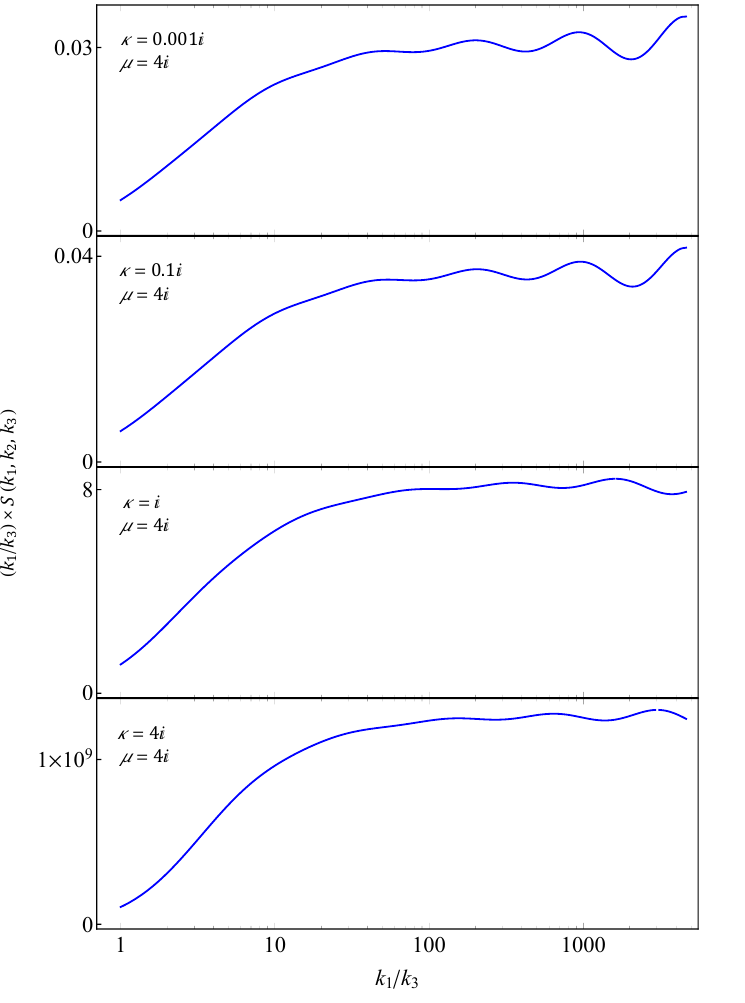
Figure 10 . The (cid:12)gure shows the clock signal from the bispectrum. Here we set the momentum to be in the z-direction and hence we set k = 1. We can see the suppression of the clock 3 z =k 3 signal as the electric (cid:12)eld increases. The frequency of the clock signal remains unchanged as the change in velocity of the produced particles occurs in the subhorizon and remains stationary during horizon crossing. Hence, no change in frequency of the oscillatory signal would be seen. However, the amplitude of the oscillatory signal would increase as the magnitude of the electric (cid:12)eld strength